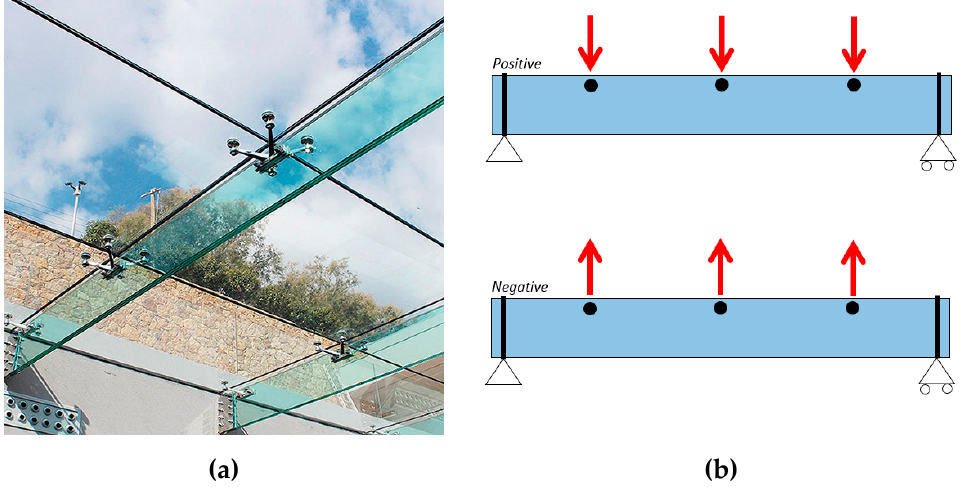
Figure 2. Example of ( a ) laterally restrained (LR) glass beams with discrete mechanical restraints and ( b ) typical loading configurations associated with positive or negative bending effects.